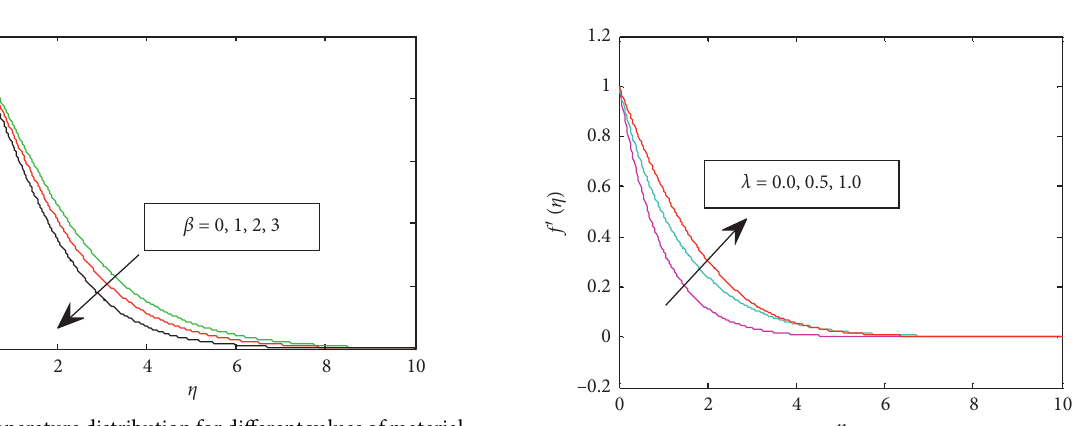
Figure 11: Temperature distribution for different values of material parameters.